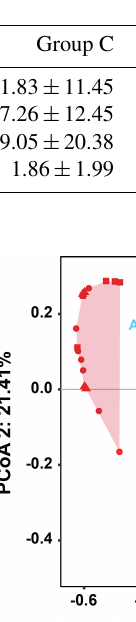
Table 1. The percentages (%) (average ± standard deviation) of diatoms, dinoflagellates, cyanobacteria, and Chrysophyceae in the four groups.